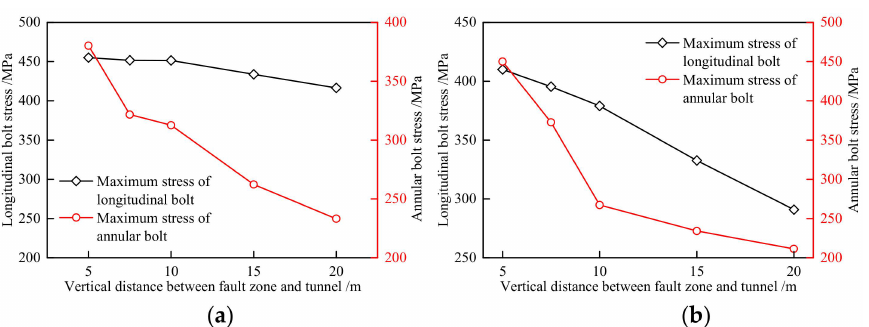
Figure 21. Effect of the vertical distance h on the maximum stress of joint bolts: ( a ) normal faulting condition and ( b ) reverse faulting condition.